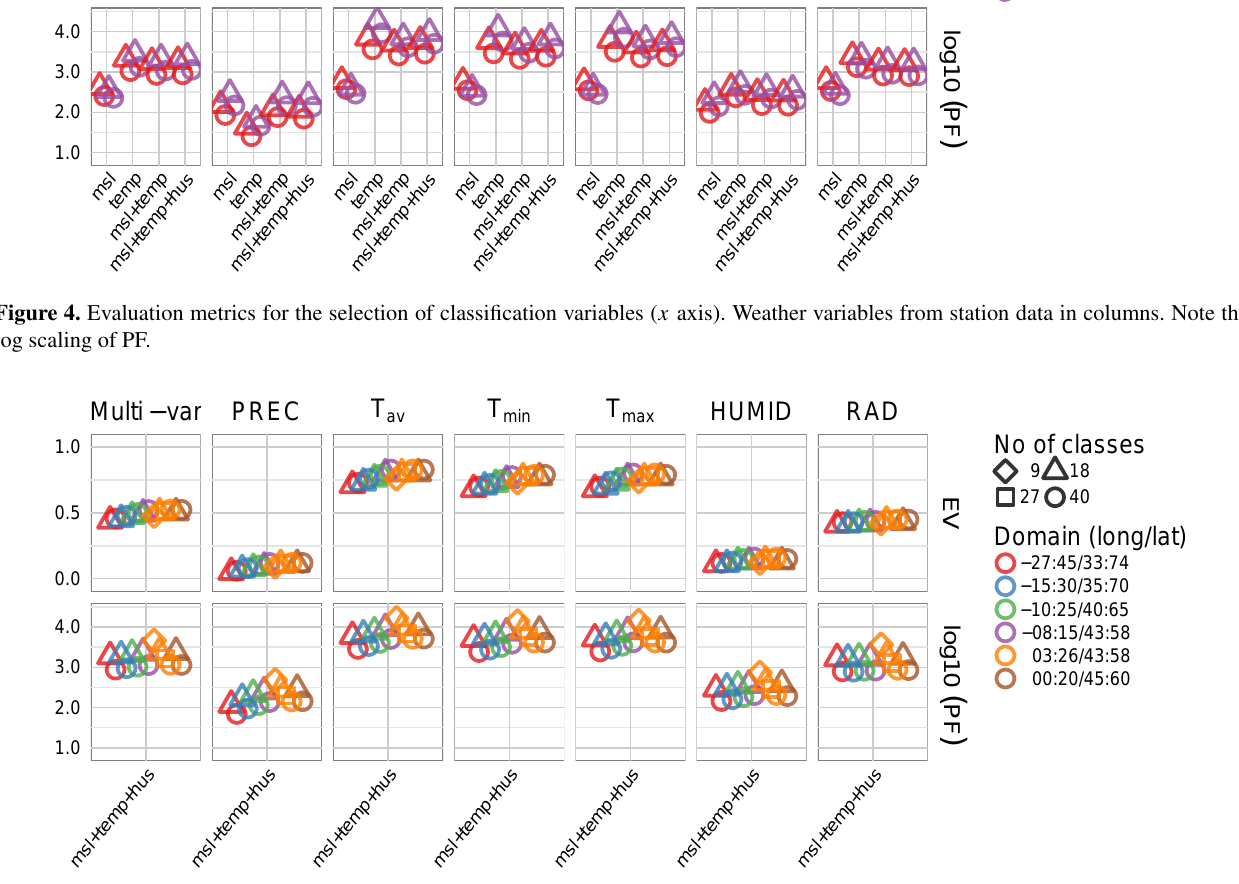
Figure 5. Evaluation metrics for the chosen classification variables, combining results of selection steps 2 and 3. It aims at selecting (a) the best spatial domain (colour scale), and then (b) selecting the best number of classes (point